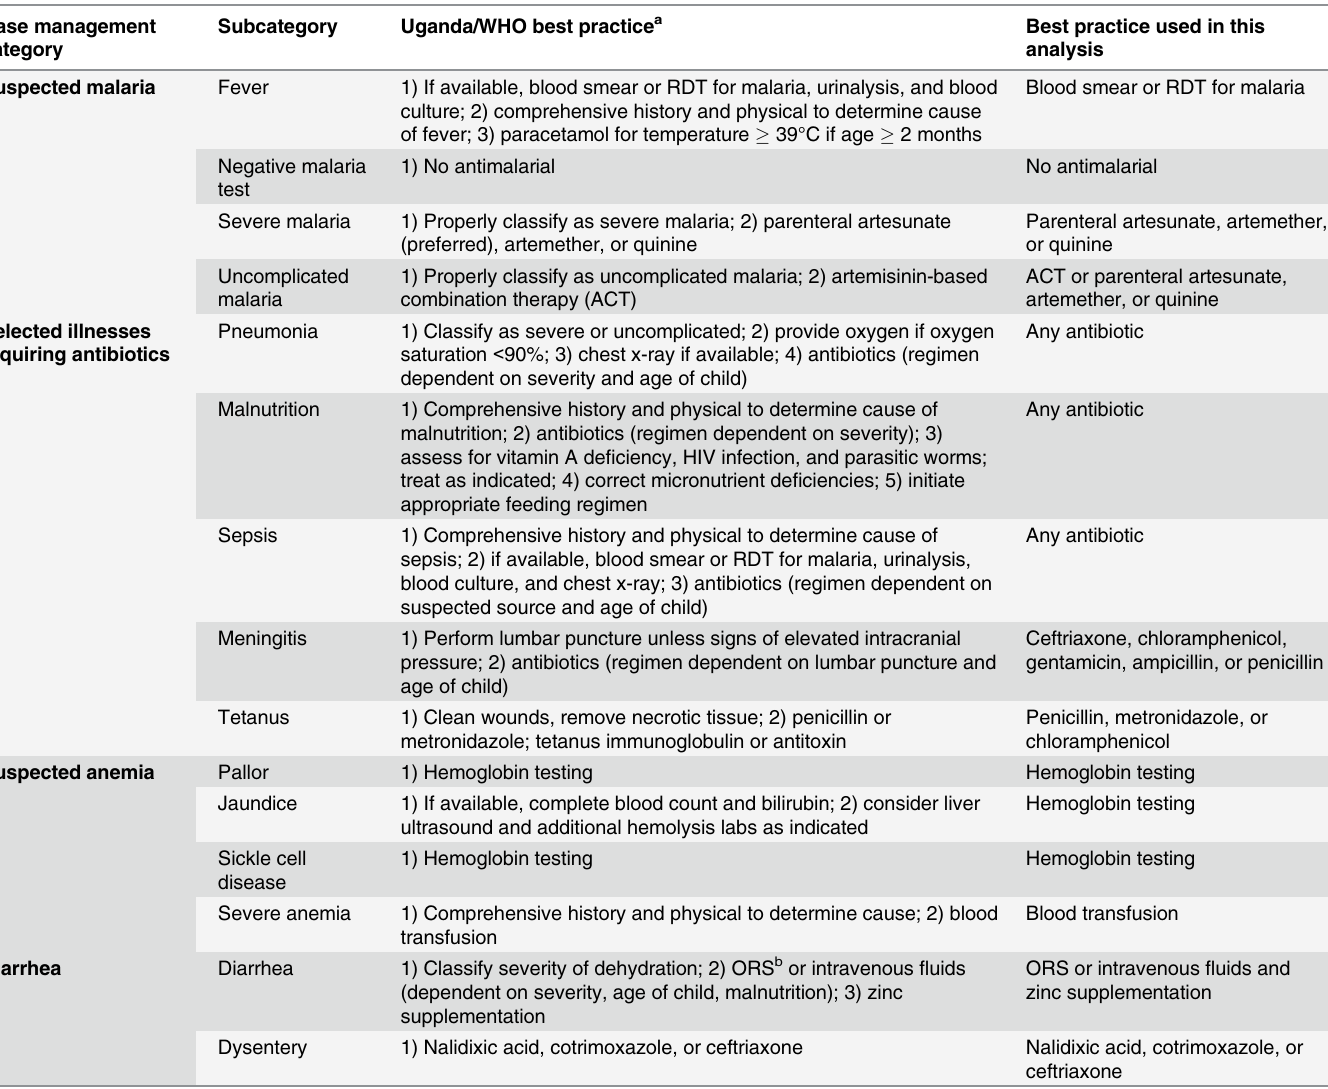
Table 1. Summary of case management best practices defined by Uganda/WHO clinical guidelines and best practices used in this analysis. Case management